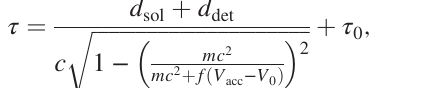
FIG. 10. Electron time-of-flight τ as a function of accelerator voltage V final electron beam energy U as a function of accelerator voltage which was calculated using Eq. (6) with f and V 0 the fitted